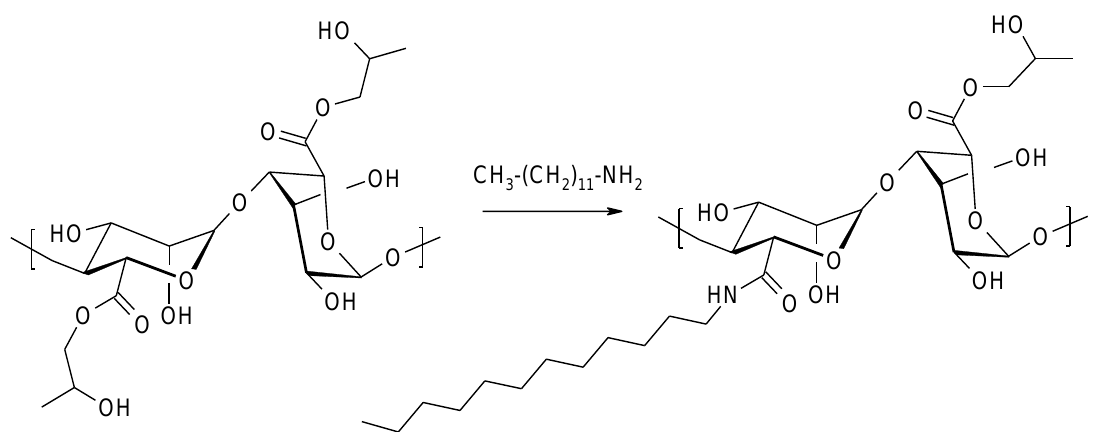
Figure 17. Synthesis of amides of alginates in the reaction of propylene glycol esters of alginates with amines.